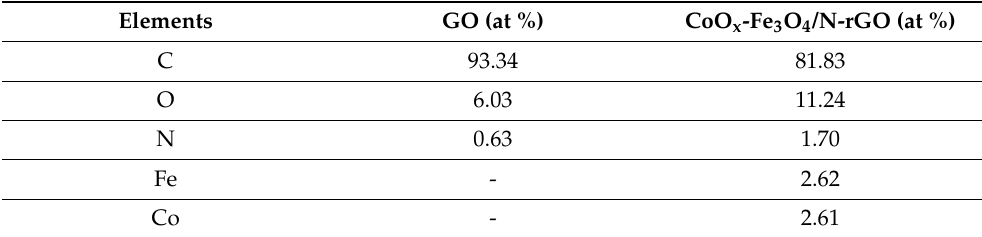
Table 1. Elemental composition data obtained from XPS